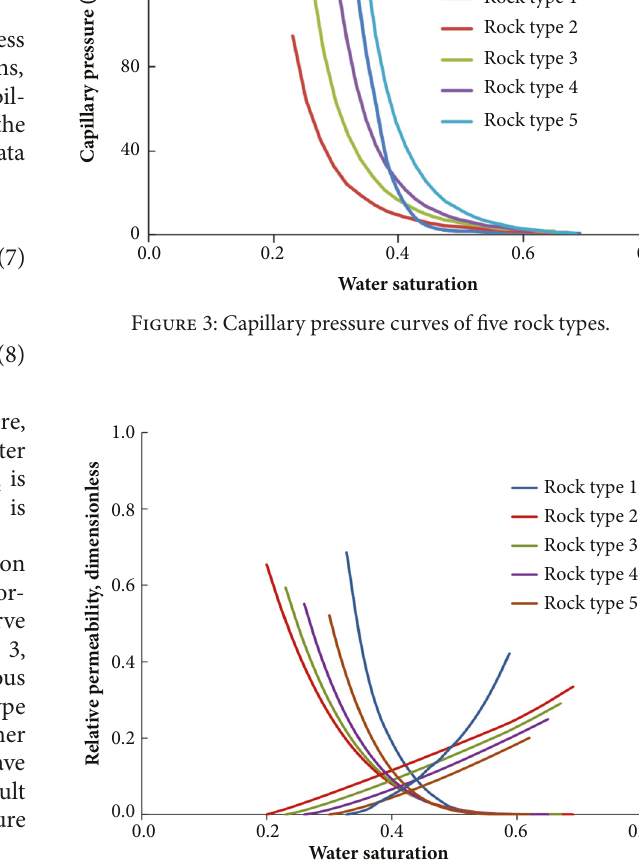
Figure 4: Relative permeability curves of five rock